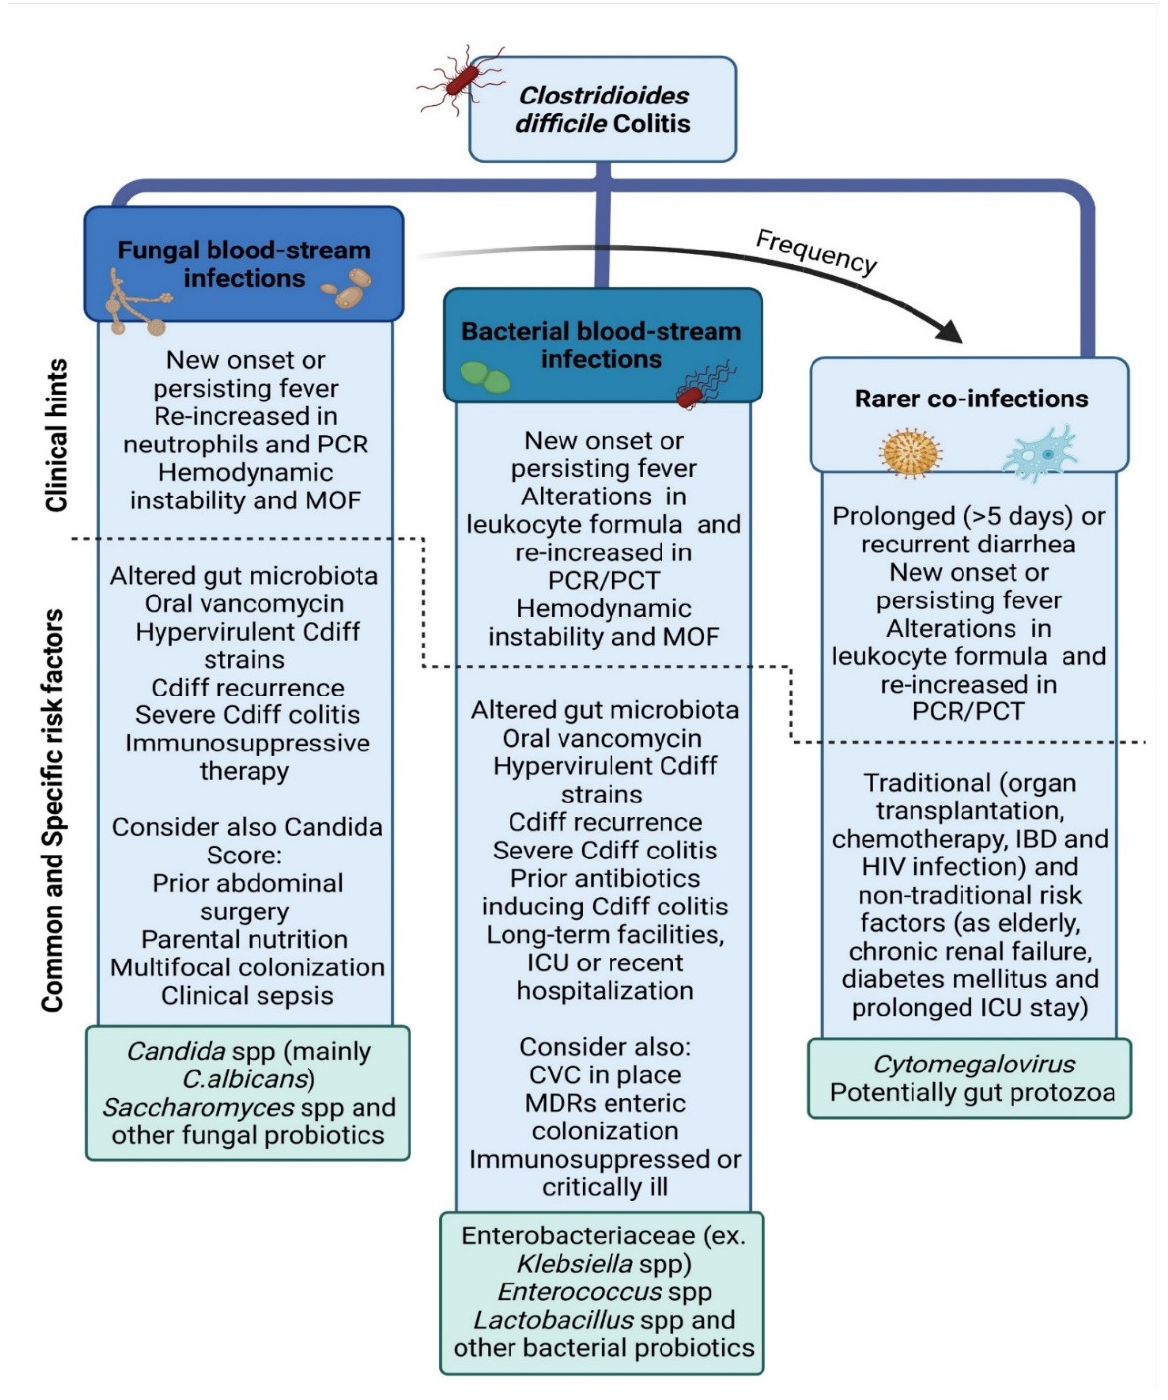
Figure 2. Clinical changes, microbial epidemiology, and risk factors of co-infections in Clostridioides difficile colitis. Legend: PCR, C reactive protein; MOF, multi organ failure; Cdiff, Clostridioides difficile ; spp., species; PCT, procalcitonin; ICU, intensive care unit; CVC, central venous catheter; MDRs, multi-drug resistant bacteria; IBD, inflammatory bowel diseases; HIV, Human immunodeficiency virus.